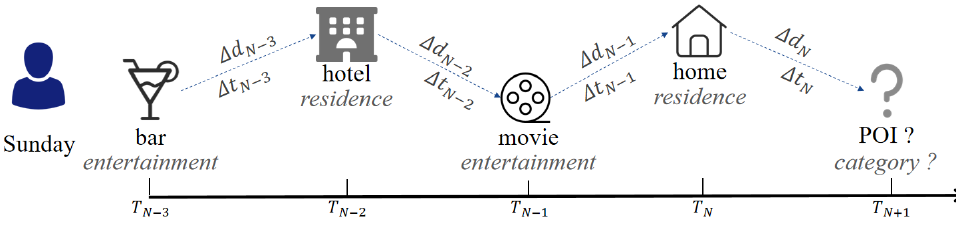
Figure 1. An example of the next POI